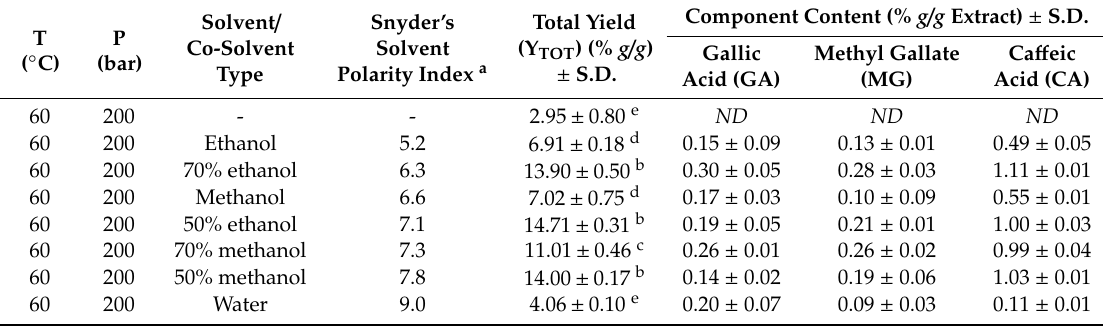
Table 2. Total yield and component composition of Supercritical Fluid Extraction Labisia pumila leaf